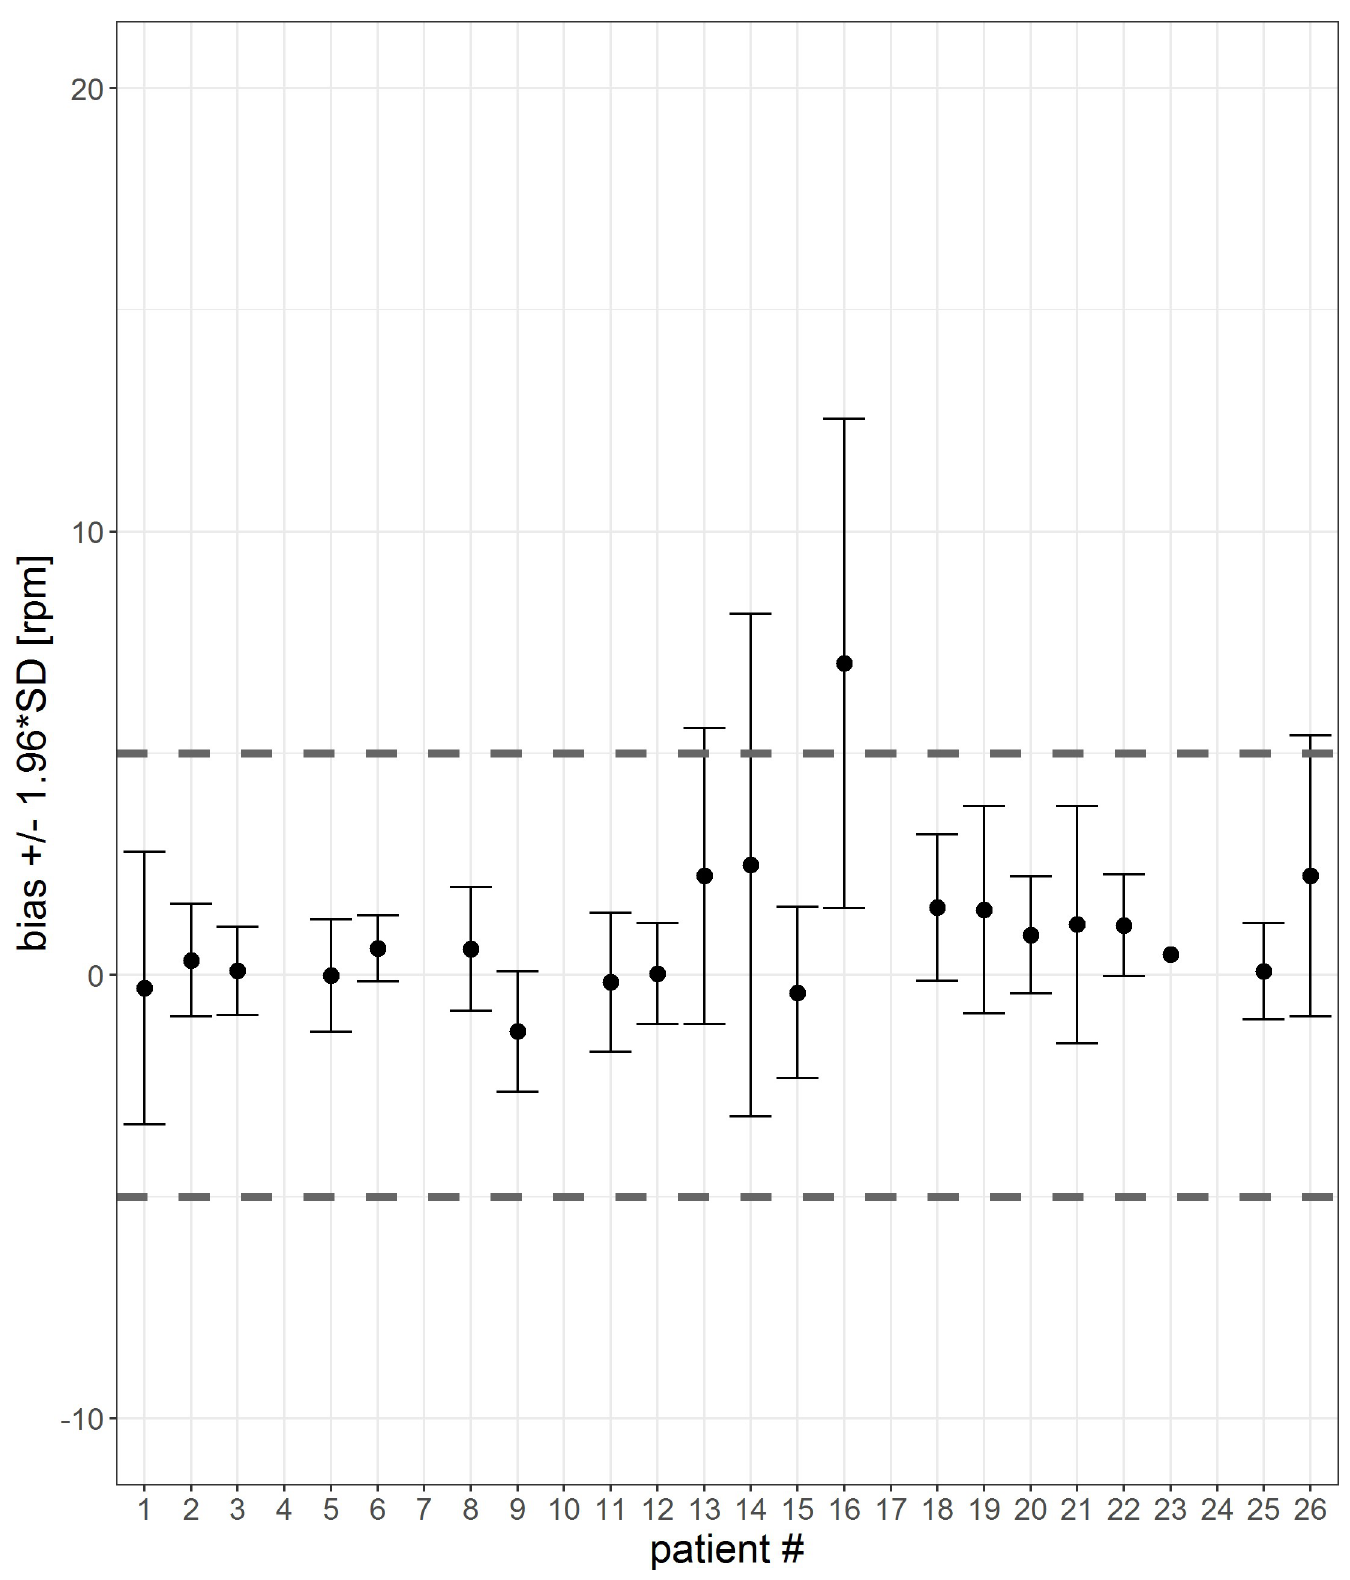
Fig 13. Error bar of each patient for a 5-min-interval. The mean differences and confidence interval (bias +/- 1.96 � SD) for each patient are plotted. Difference was calculated by subtracting patient monitor data from Healthdot data, based on 5-min averages. The gray dashed lines indicate the required threshold of 5 rpm. https://doi.org/10.1371/journal.pone.0247903.g013 PLOS ONE | https://doi.org/10.1371/journal.pone.0247903 April 28,